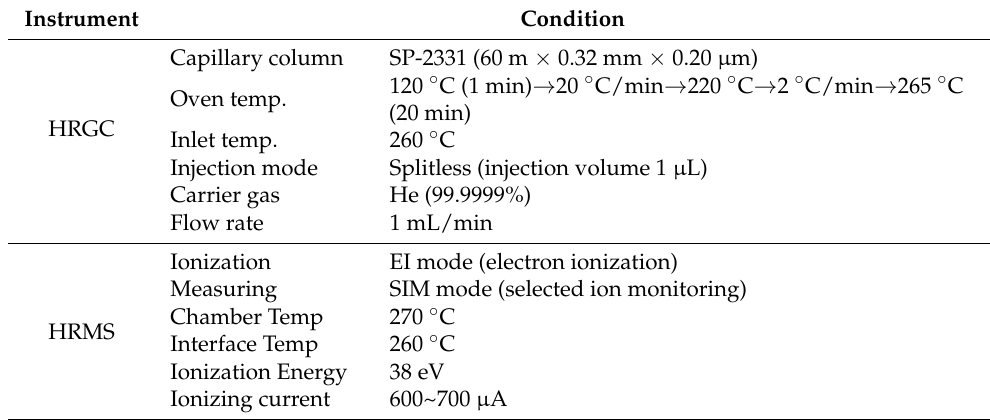
Table 3. HRGC/HRMS analytical conditions.